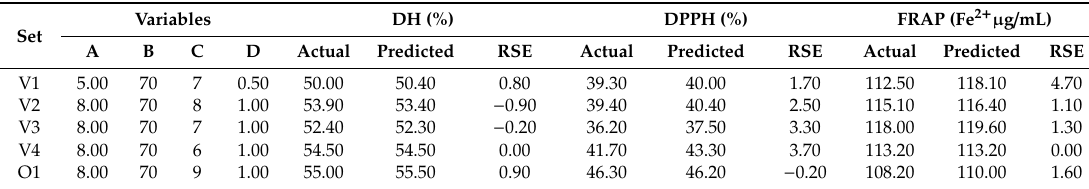
Table 5. Actual and predicted responses for the model